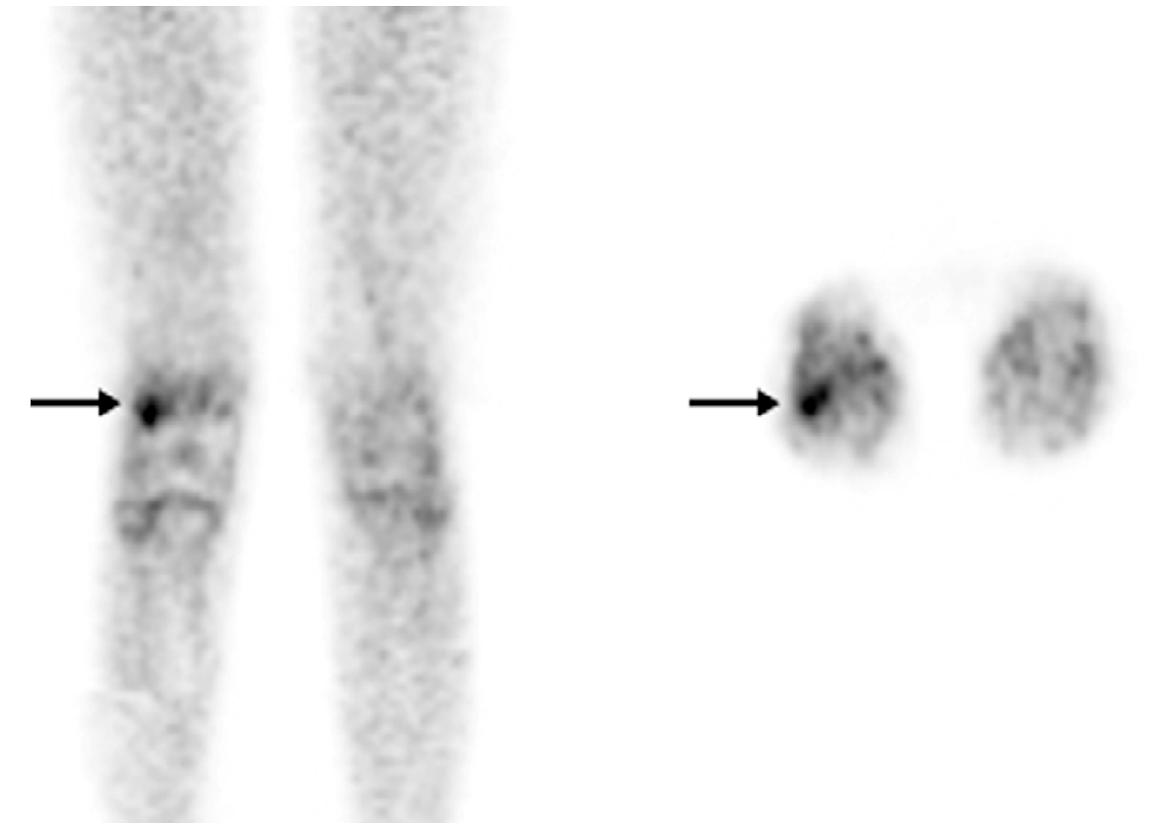
Figure 4. [ 18 F]FDG-PET in osteomyelitis. Osteomyelitis of the right femur. An [ 18 F]FDG-PET scan was recommended for a 12-year-old patient with bacteremia and right knee pain instead of labeled leukocyte imaging due to leukopenia. On the coronal ( left ) and axial ( right ) images, there is focal hypermetabolism (SUV max: 2.5) in the lateral condyle of the right femur (arrow) (with permission from [44]).